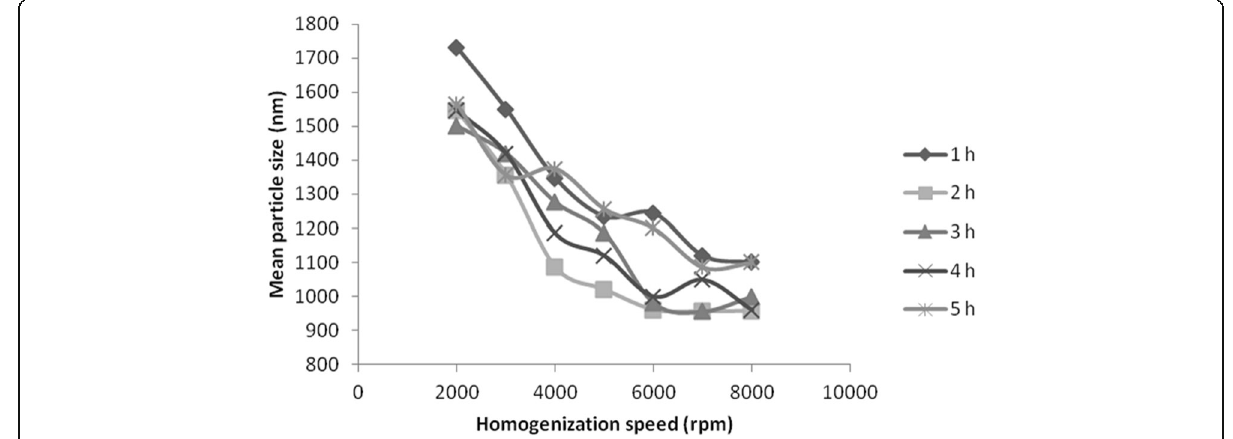
Fig. 2 Study of homogenization speed on mean particle size at different homogenization time